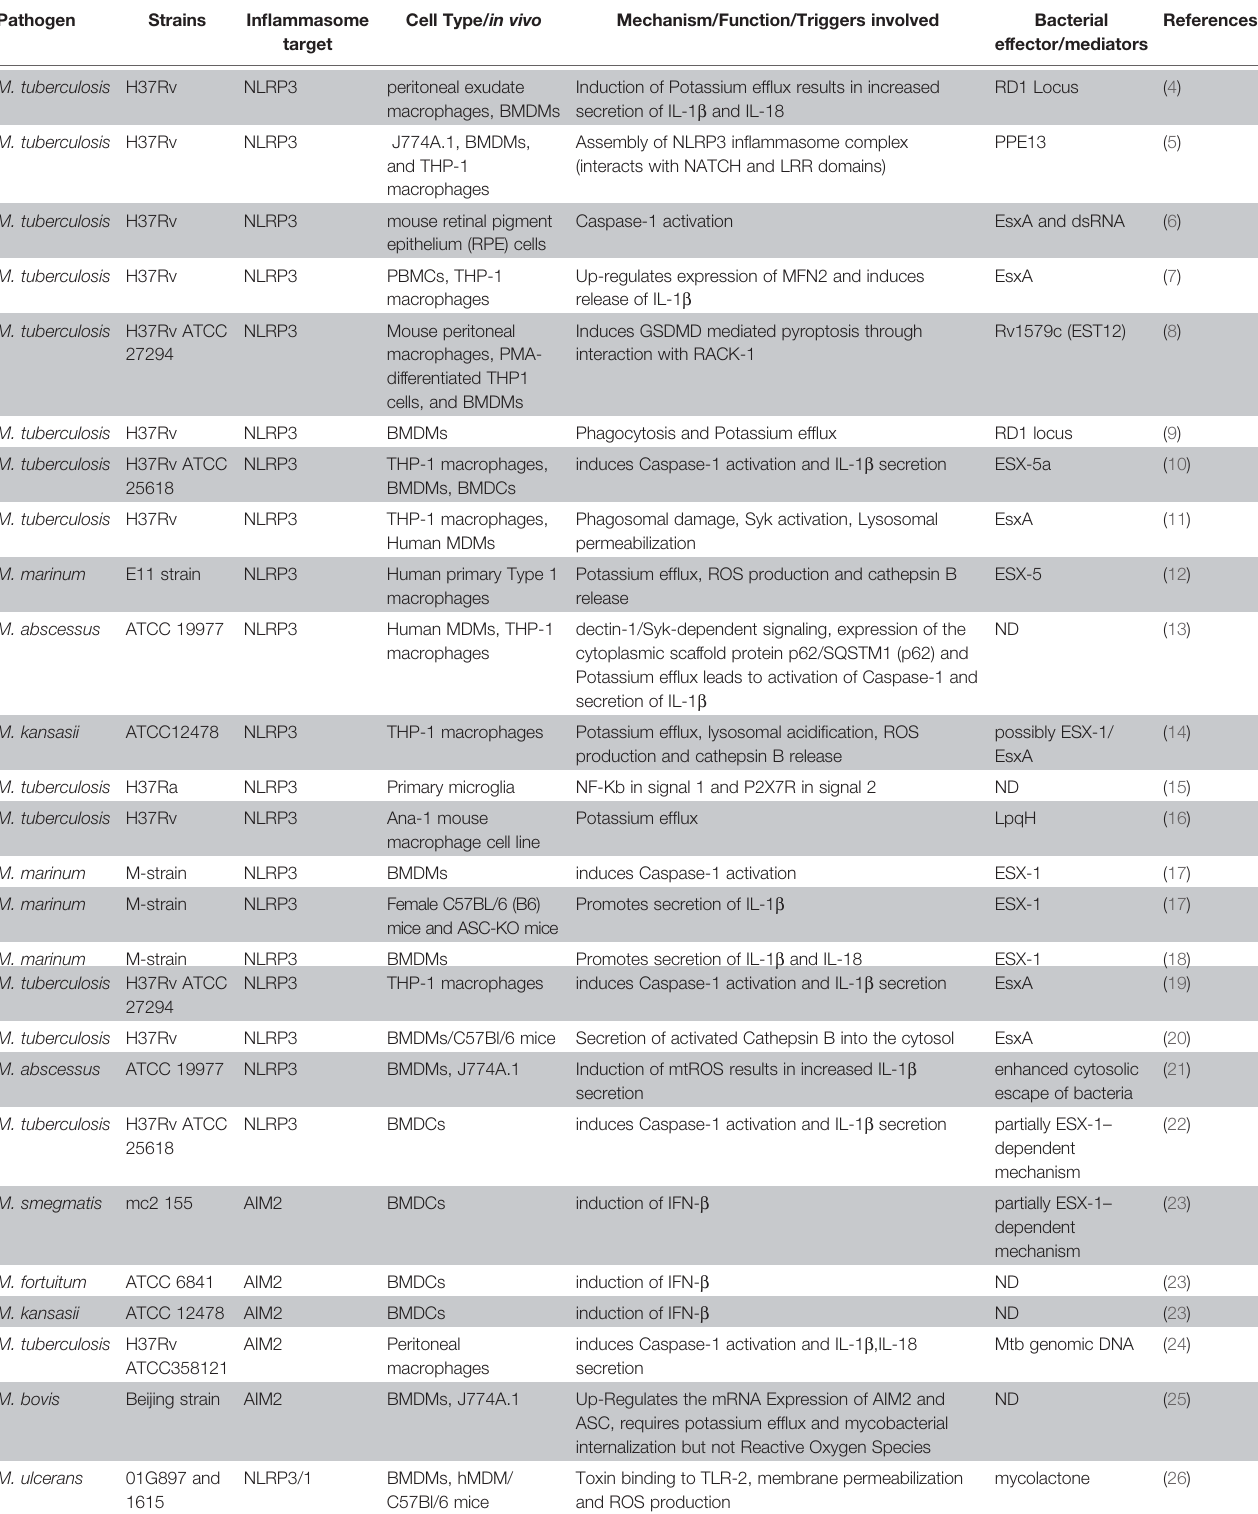
TABLE 1 | Summary overview of different mycobacterial species and effectors involved in activation of either NLRP3 or AIM2 in fl ammasome.